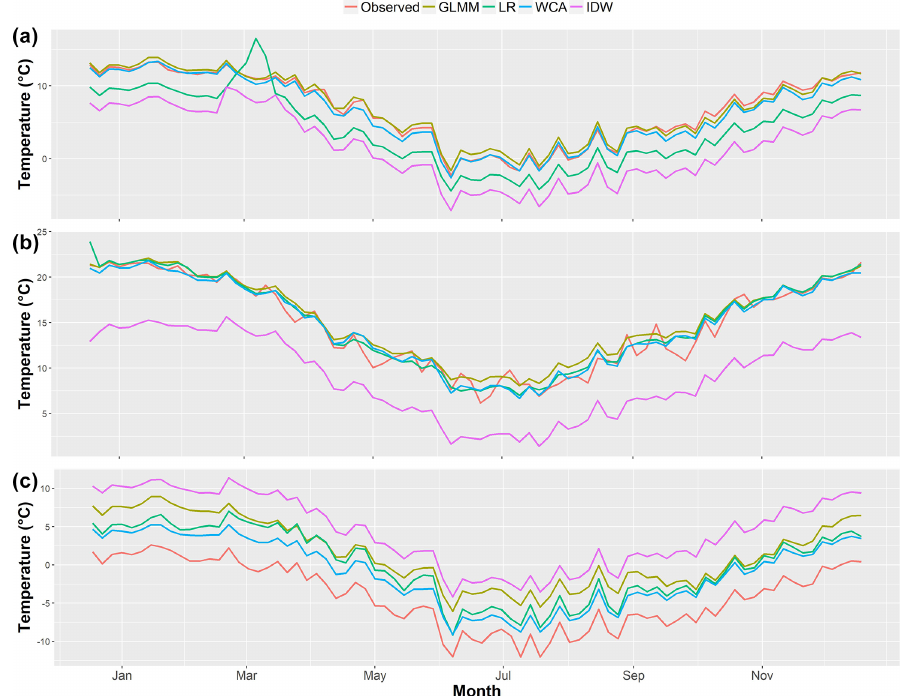
Figure 5. Daily temperature averaged over the 5 years of analysis for gauge (a) site 27 (Lagunitas), (b) site 18 (330019) and (c) site 28 (MP; all curves were smoothed using the LOESS method (Jacoby, 2000) with α = 0 . 045 – this is similar to a moving average and is used to facilitate the visualisation of the main trends only).